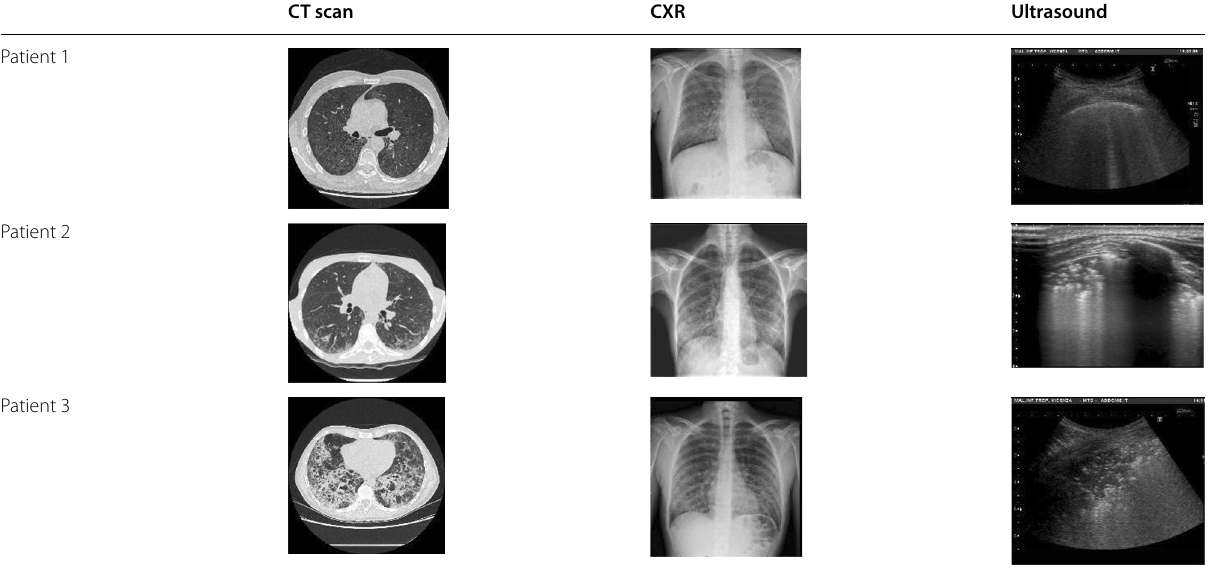
Table 4 Comparison of findings on CT scan, CXR, and ultrasound of three patients with Pneumocystis jirovecii pneumonia